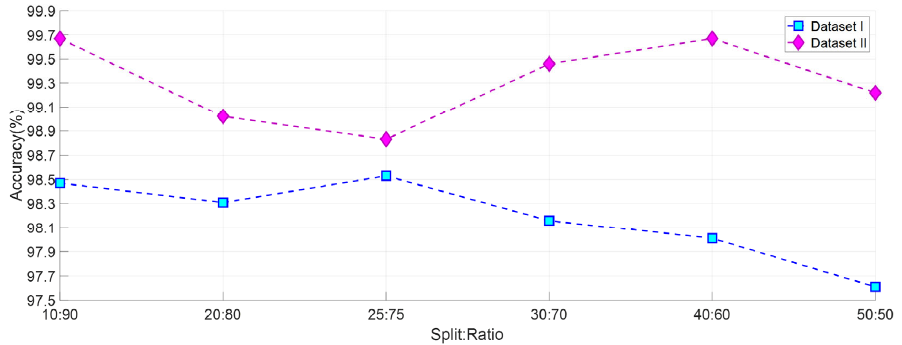
Figure 8. Accuracy graph obtained using SVM classifier for various k ‐ fold CVs.